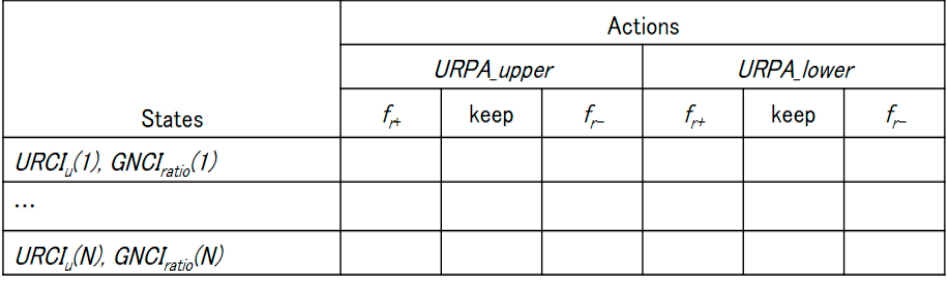
Figure 5. Q-table structure for Q-LBR.